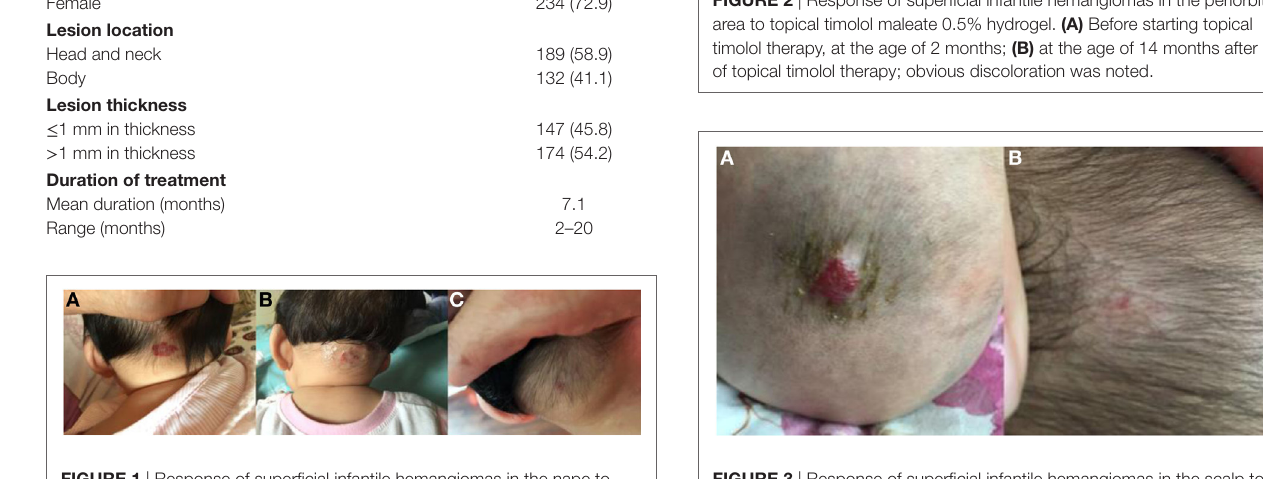
FigUre 1 | Response of superficial infantile hemangiomas in the nape to topical timolol maleate 0.5% hydrogel. (a) Before starting topical timolol therapy, at the age of 3 months; (B) 1 month after starting topical timolol therapy; (c) at the age of 6 months after end of topical timolol therapy; obvious discoloration and regression in size were noted.